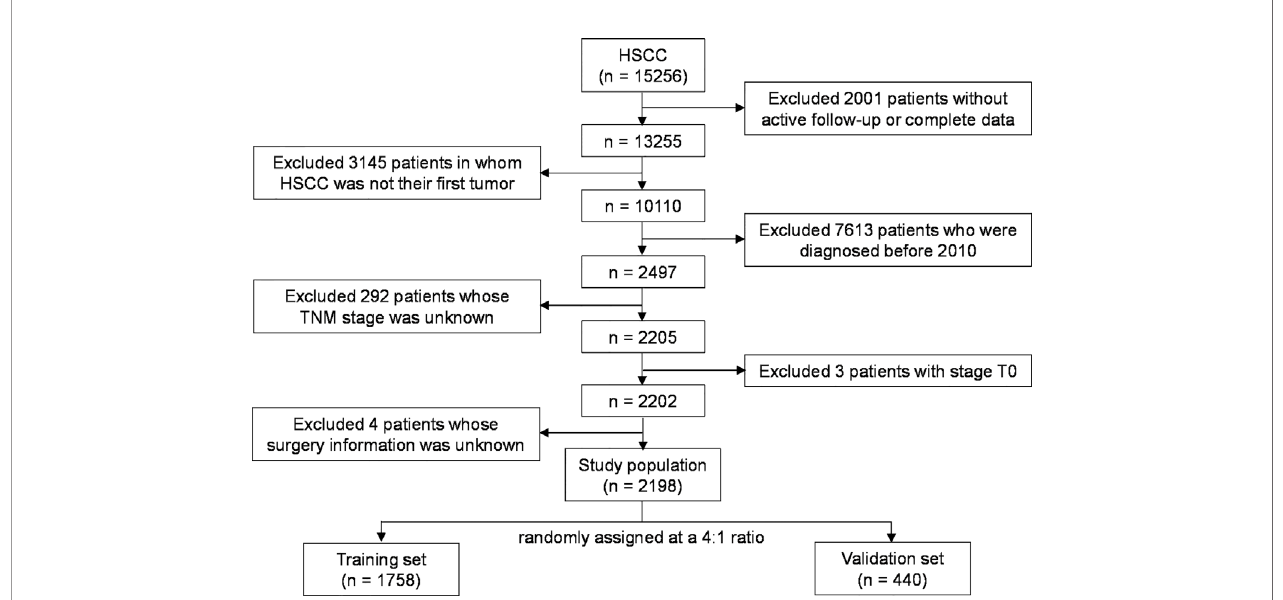
FIGURE 1 | Screening